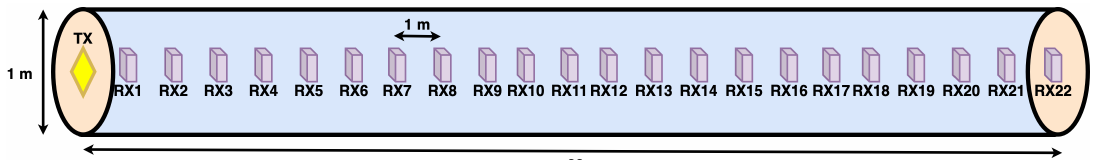
Figure 1. A recreated illustration of the gas pipeline simulated in [89]. An LED is located at the head of the pipeline and 22 Rx test points placed within